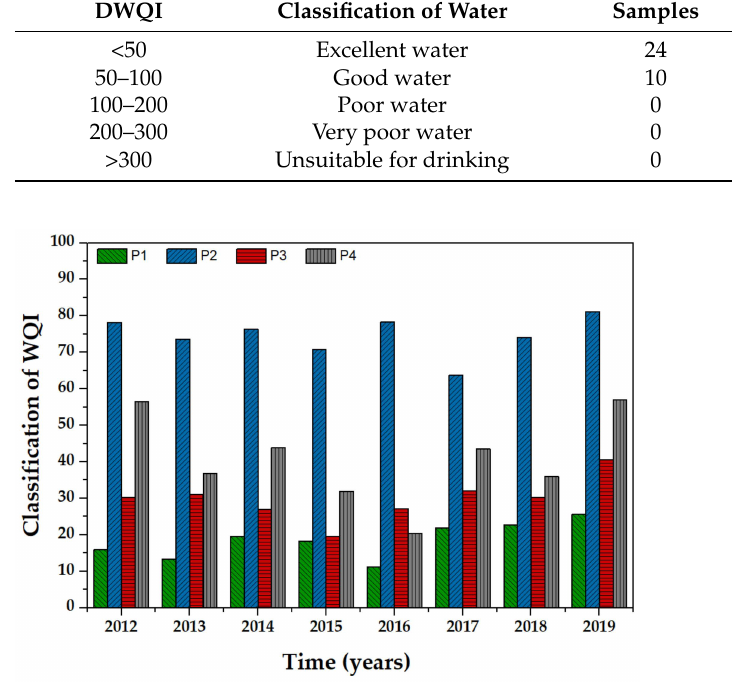
Figure 10. Variation of the water quality index in the sampling wells of the Cuernavaca